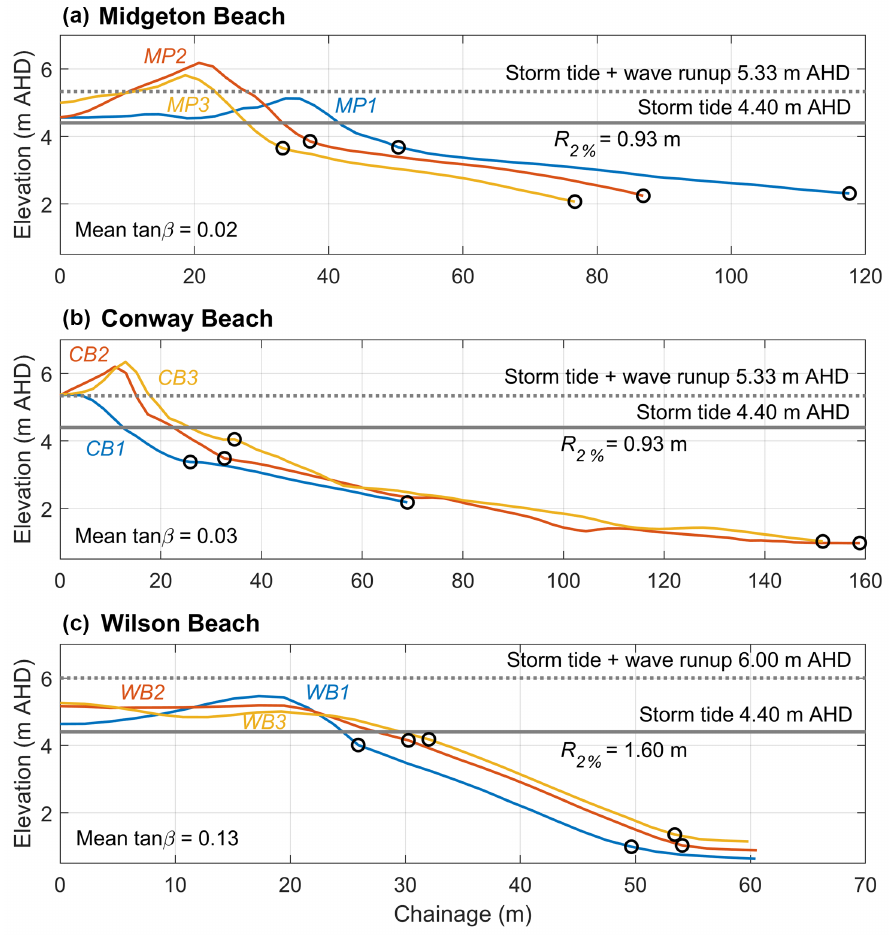
Figure 6. Pre- Debbie beach profiles (July–August 2016) at (a) Midgeton Beach, (b) Conway Beach and (c) Wilson Beach (profile locations in Fig. 7). Maximum storm tide elevation was taken from the nearest gauge (Laguna Quays) (grey solid line), and maximum water elevation (grey dashed line) was defined as R 2% + storm tide elevation. R 2% corresponds to the expected level of exceedance of 2% of the wave runups during wave conditions at the time of maximum storm tide elevation ( H s0 5m L 0 131m, at 12:00 28 March). R 2% was calculated for each location based on the mean slope (tan β ) of the profiles. The locations at which tan β was calculated for each profile are shown (base of dune to toe of upper beach, black